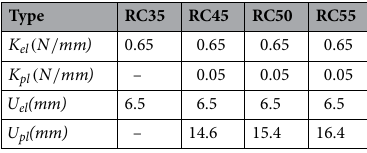
Table 3. Elastic and plastic stiffness and deflection from the